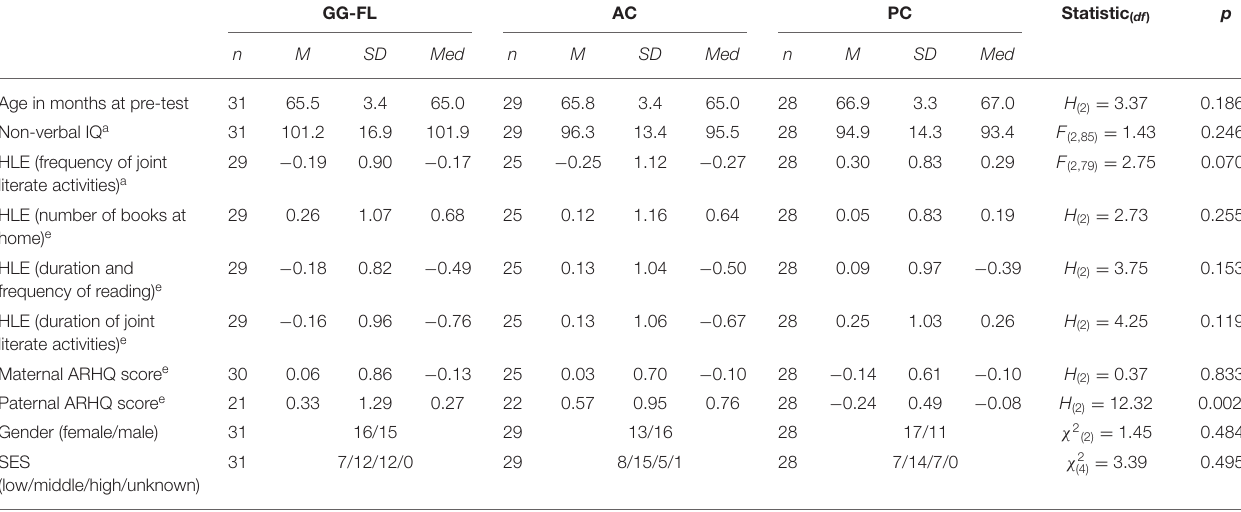
TABLE 1 | Demographic characteristics of the participants.